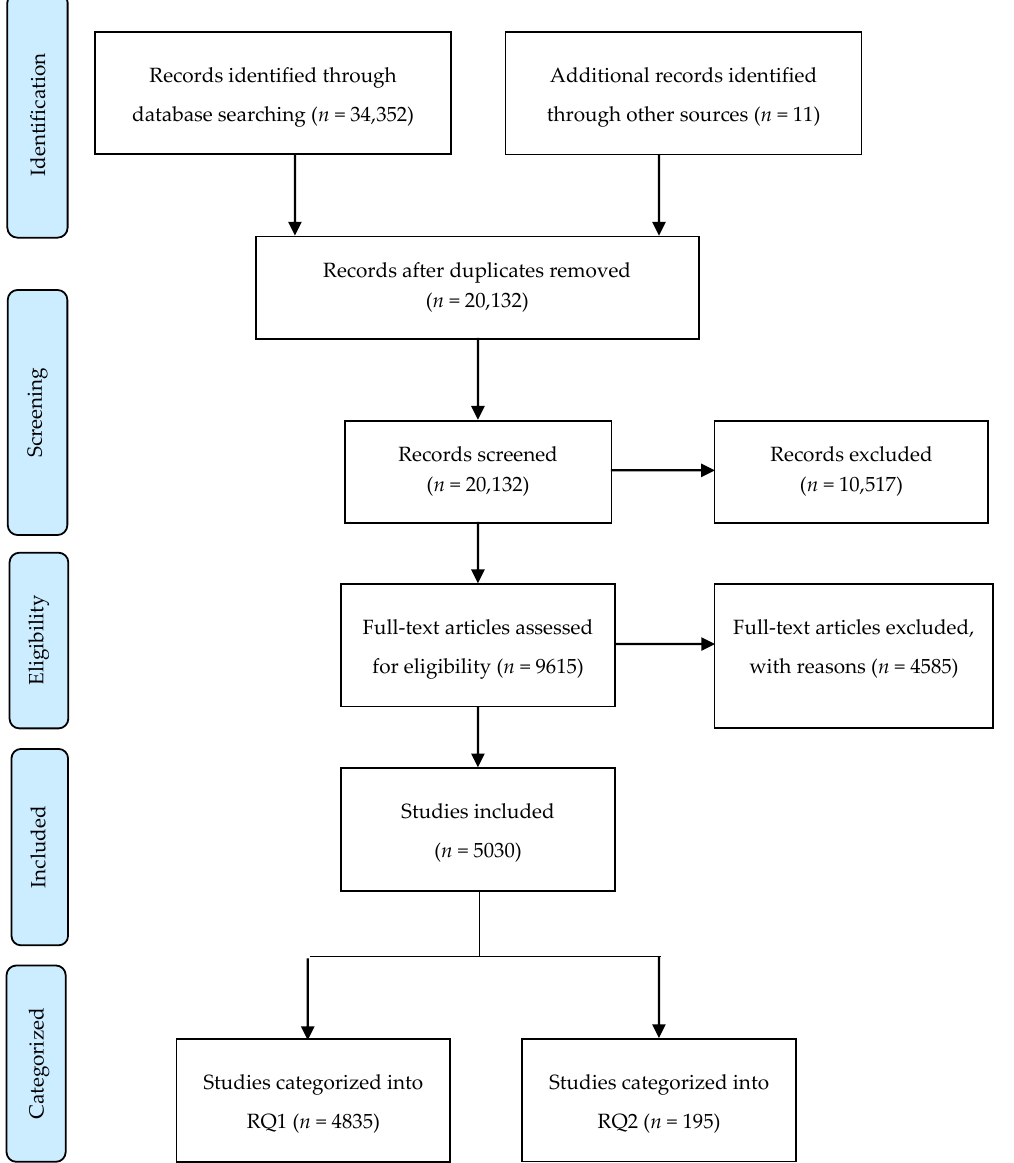
Figure 1. Preferred Reporting Items for Systematic Reviews and Meta-Analyses (Prisma) flow diagram. From Moher D. et al. [29].